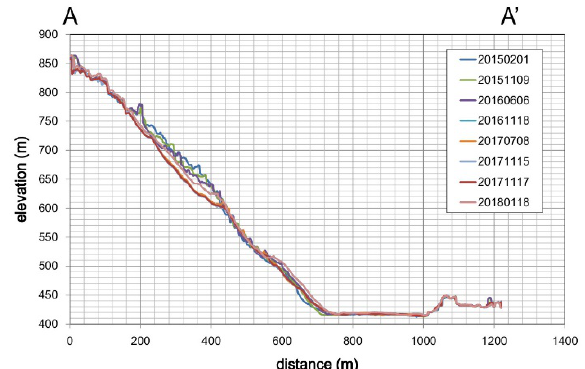
Figure 4. Geomorphologic profiles across landslide area